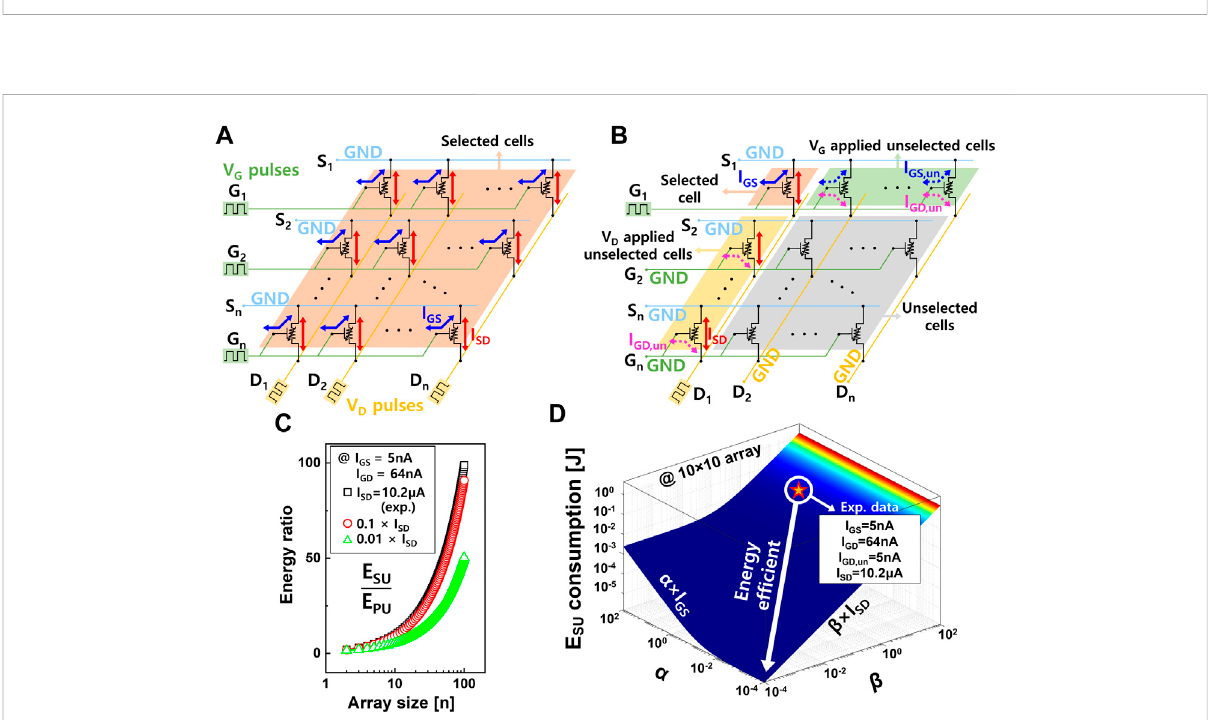
FIGURE 2 The schematic illustrations of (A) PU and (B) SU in n × n ECRAM array. Unlike the PU operation, where only selected cells are involved, four regimes inthearrayfor SUare classi fi edbasedon voltageconditions. (C) Calculated Eratiowithrespectto thearraysize.The ratiocanbeminimized by reducing I SD at a given I GS . (D) The three-dimensional plane graph showing E SU as a function of I SD and I GS